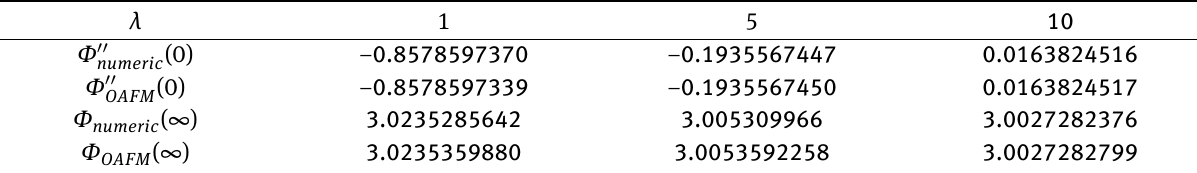
Table 4: Values of Φ ′′ (0) and Φ (∞) in the case of stretching flow with suction sheet m = 2 , α = 3